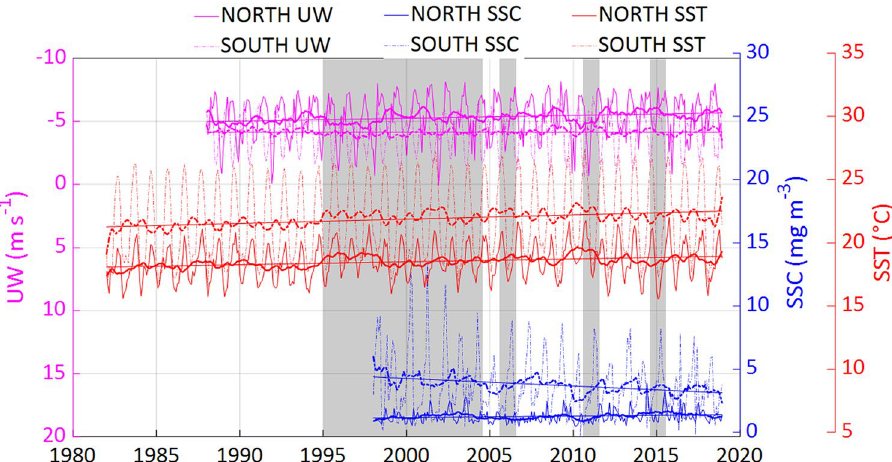
Figure 2. Monthly means and 13-term smoothing average of sea surface temperature (SST, °C), sea surface chlorophyll-a concentration (SSC, mg m −3 ) and upwelling wind (UW, m s −1 ), processed for the areas to the north of Cap Blanc (12–21°N, plain line) and south of Cap Blanc (21–30°N, dashed line). The periods covered by the sea surveys (1995 to 2004, 2006, 2011 and 2015) are shaded in grey.